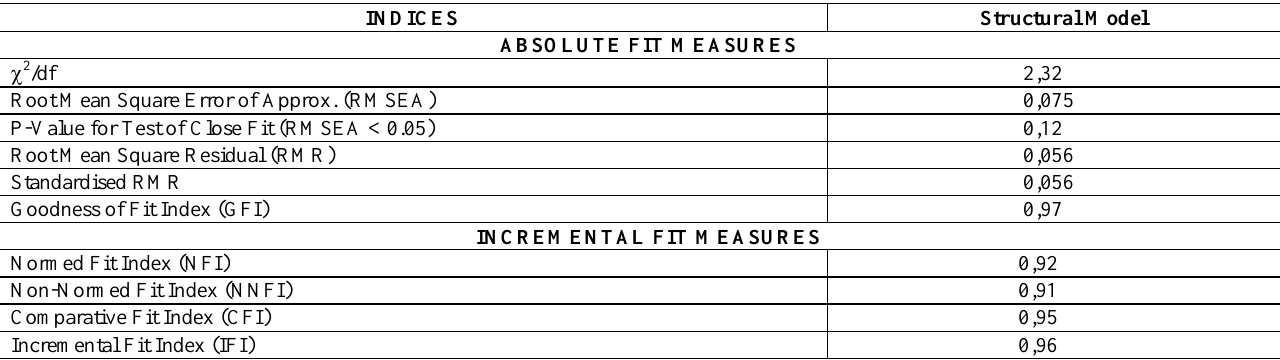
Table 5: Goodness-of-fit indices for structural